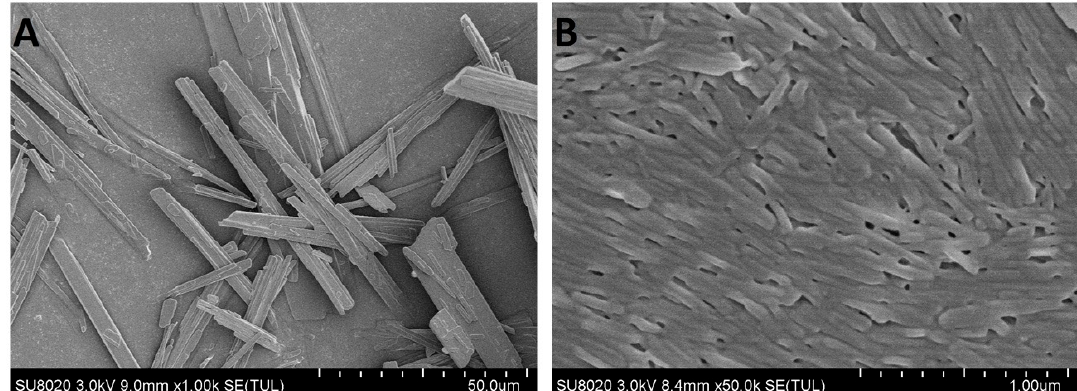
Figure 4. Scanning electron microscope (SEM) images of ( A ) CLX crude powder and ( B ) optimized CLX-NC.